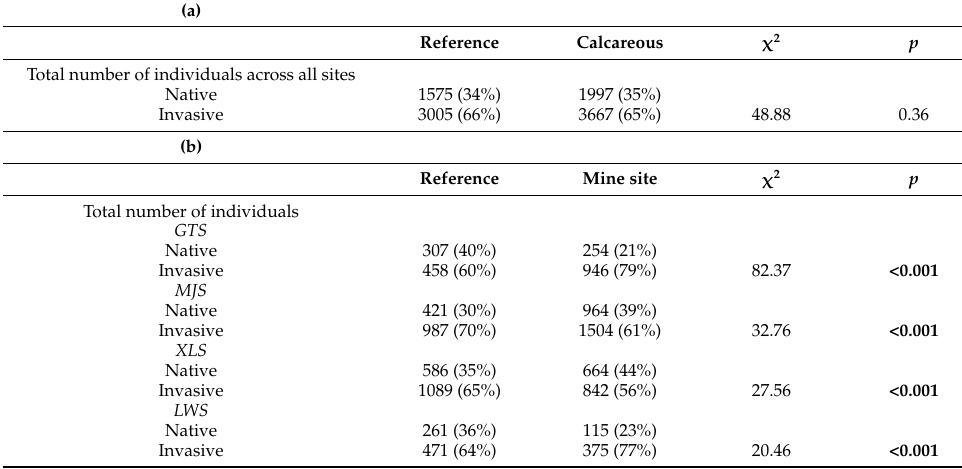
Table 2. Chi-square test results comparing the number of individuals of invasive versus native species: (a) across all sites, (b) among site pairs (mine sites and adjacent reference sites). Bold p -values indicate statistically significant